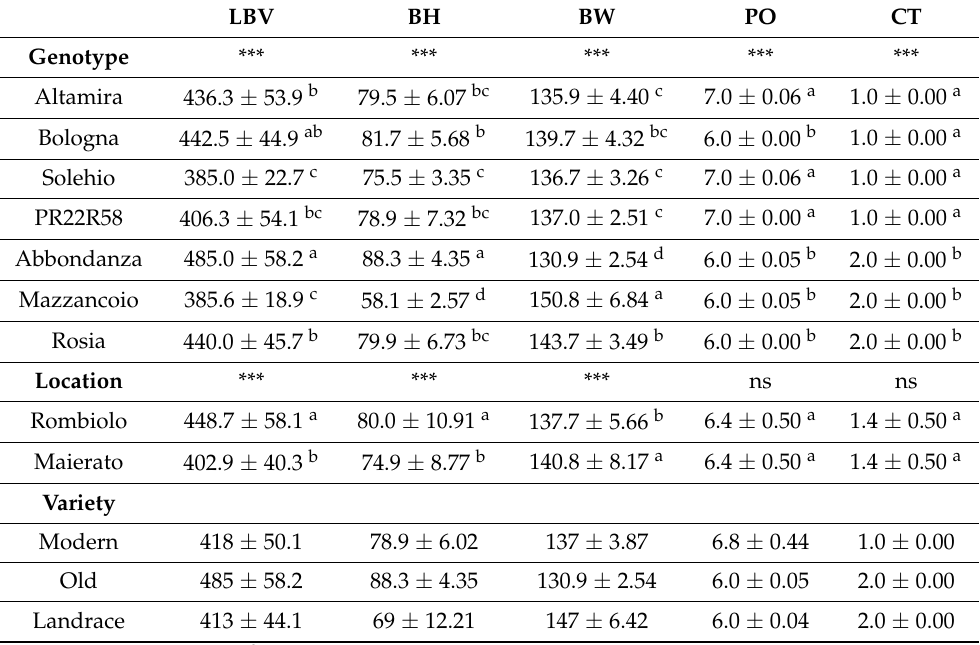
Table 5. Quality characteristics of bread obtained from the different